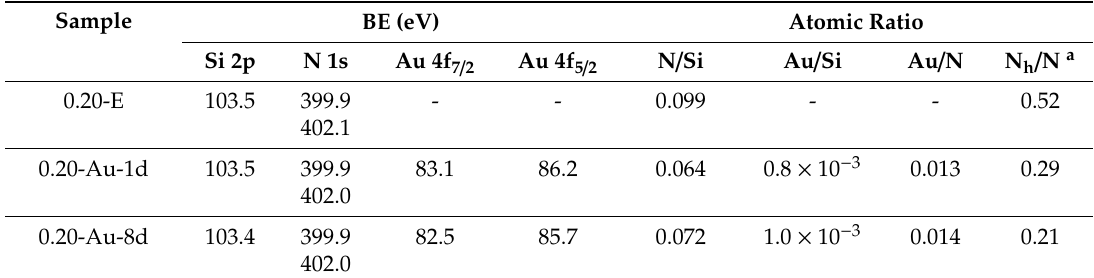
Table 4. Core-level binding energies and atomic ratios calculated from XPS